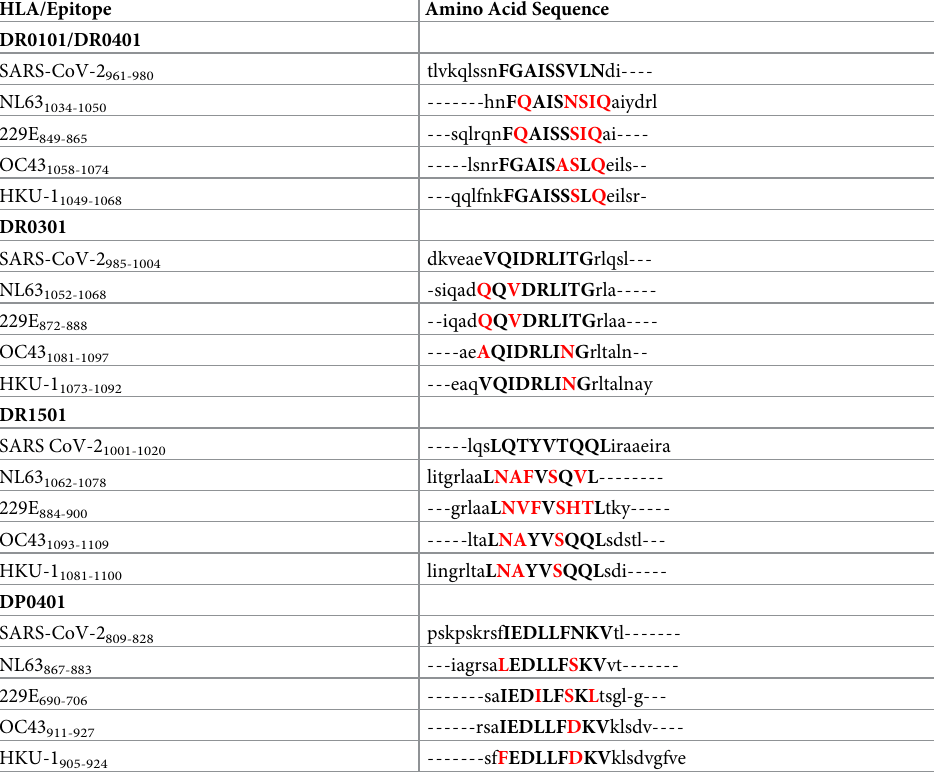
Fig 3. Summary of total frequencies of SARS-CoV-2-reactive CD4+ T cells from ex vivo tetramer staining of PBMC from SARS-CoV-2 exposed and unexposed individuals. (A) All HLA frequencies. (n S = 31 exposed, 22 unexposed; n M = 22 exposed, 18 unexposed; n N = 22 exposed, 18 unexposed). (B) DR0101-specific frequencies. (n = 5 exposed, 3 unexposed). (C) DR0301/DRB3-specific frequencies. (n = 4 exposed, 4 unexposed). (D) DR0401-specific frequencies. (n S = 5 exposed, 5 unexposed; n M = 4 exposed, 5 unexposed; n N = 4 exposed, 5 unexposed). (E) DR1501/ DRB5-specific frequencies. (n = 9 exposed, 6 unexposed). (F) DP0401-specific frequencies. (n = 8 exposed, 6 unexposed). Student’s unpaired t-test; � p � 0.05, �� p � 0.01, ��� p � 0.001, ���� p � 0.0001. https://doi.org/10.1371/journal.ppat.1010203.g003 regions of ccCoV S epitopes. The CD154 upregulation assay, a potentially more sensitive approach in detecting low avidity interactions, was performed for these cross-reactivity experi- ments. Though the DR0101 S lines could not recognize any ccCoV sequences tested, the 961-980 DR1501 SARS-CoV-2 S cell line was partially activated relatively by the OC43 S 1001-1020 1093- and HKU-1 S peptides. The DP0401 SARS-CoV-2 S line was activated by 1081-1100 809-828 1109 NL63 S , OC43 S and HKU-1 S peptides, but not the homologous 229E S 867-883 911-927 905-924 690- peptide (Fig 4A). The cross-reactivity of DP0401 restricted SARS-CoV-2 S T cells was 706 809-828 also confirmed by positive staining of another DP0401 SARS-CoV-2 S line obtained 809-828 from another DP0401 COVID-19 convalescent person with DP0401 NL63 S , DP0401 867-883 OC43 S , DP0401 229E S and DP0401 HKU-1 S tetramers (Fig 4B). Slightly 911-927 690-706 1081-1100 line from a third unexposed different results were observed in a DP0401 SARS-CoV-2 S 809-828 person. For this particular SARS-CoV-2 S line, both NL63 S and 229E S tet- 809-828 867-883 690-706 ramers gave strong signals, but less than 6% of cells in this line recognized the OC43 S 911-927 Table 2. FASTA alignment of potential SARS-CoV-2/ccCoV Spike cross-reactive epitopes. Black bold indicates the putative MHC-II binding motif as predicted by NetMHCII pan 4.0. Red indicates an amino acid different from SARS-CoV-2. HLA/Epitope Amino Acid Sequence